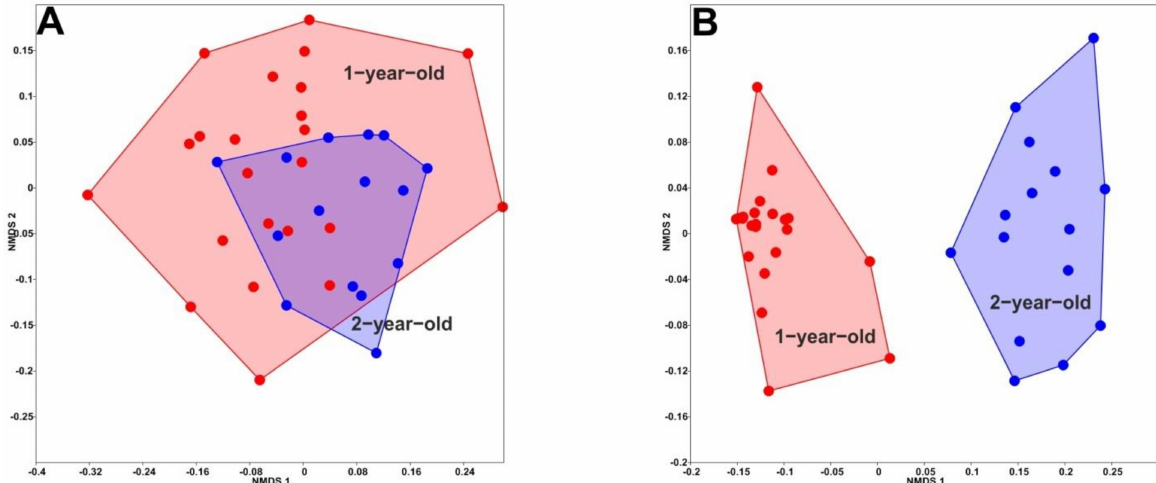
Figure 4. Nonmetric multidimensional scaling (NMDS) ordination of Scots pine seedlings of different age according to their ectomycorrhizal fungal composition; ( A ) Jaccard index and ectomycorrhizal fungal composition and abundance ( B ) Bray–Curtis